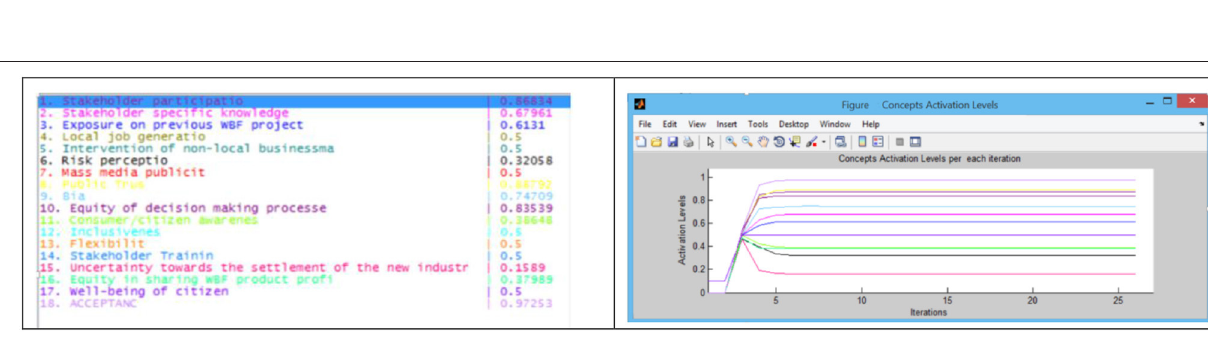
Frontiers in Energy Research | www.frontiersin.org